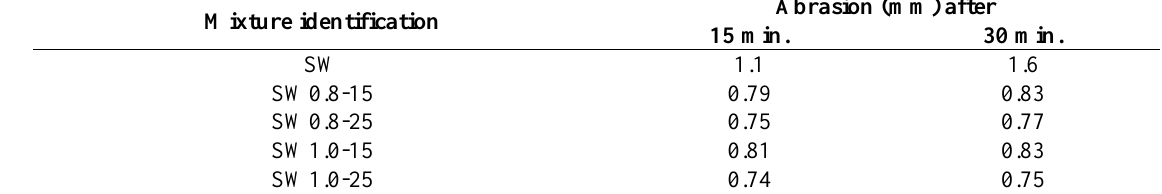
Table 10. Abrasion